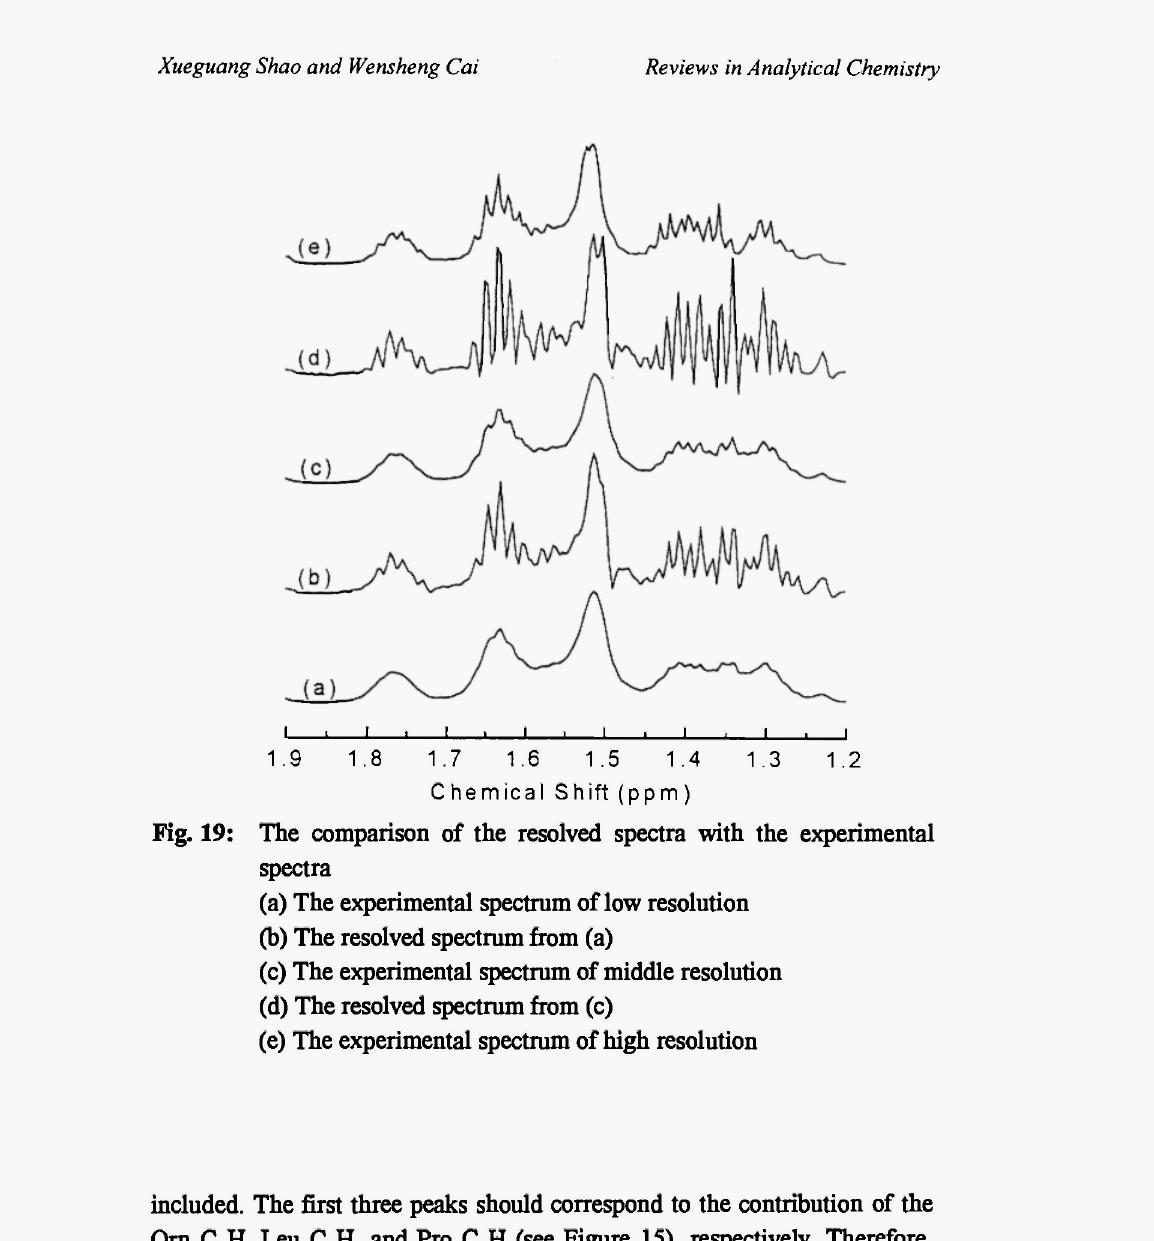
included. The first three peaks should correspond to the contribution of the Orn C H, Leu C H, and Pro CoH (see Figure 15), respectively. Therefore, a a the resolved spectra (b) and (d) are consistent with both the best resolved experimental result (e) and the theoretical spectrum. As to the overlapping peak, which should be composed of the contributions of the Val CoH (triplet) and Phe C H (quartlet), the resolved spectrum which can be consistent with a the theoretical spectrum is not obtained because of the heavy overlapping and the lack of the information in the experimental data (a) and (c).